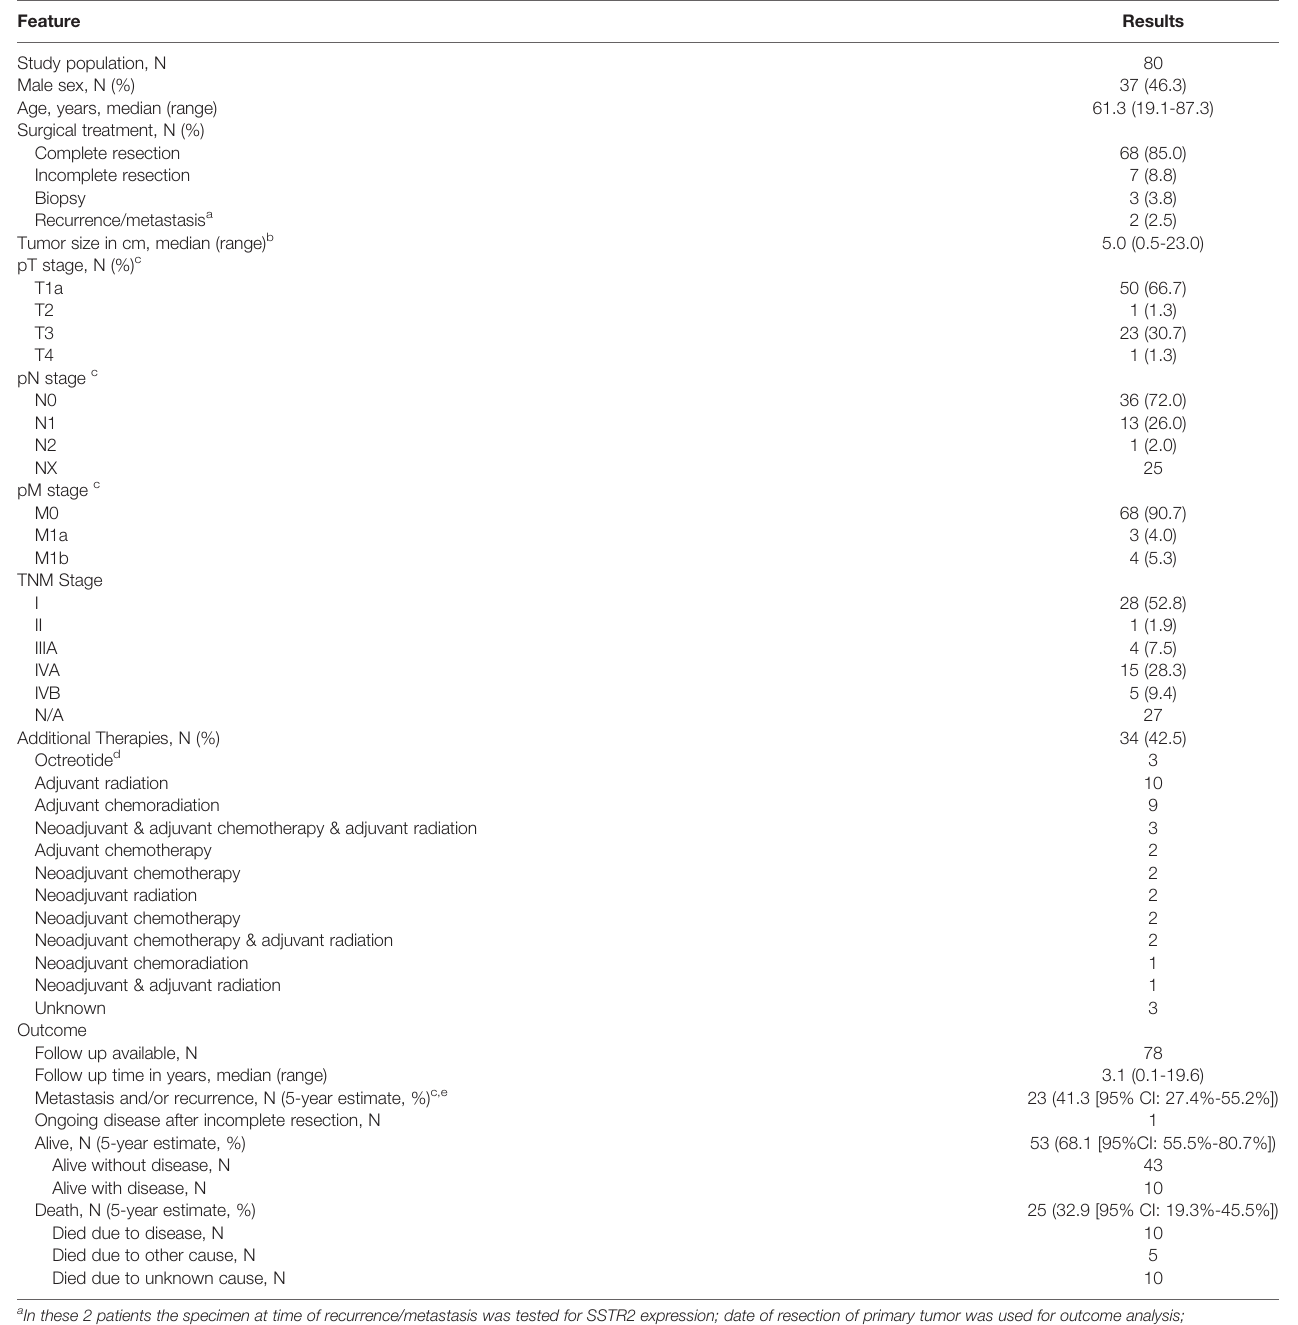
TABLE 1 | Demographics, treatment, and outcome of study